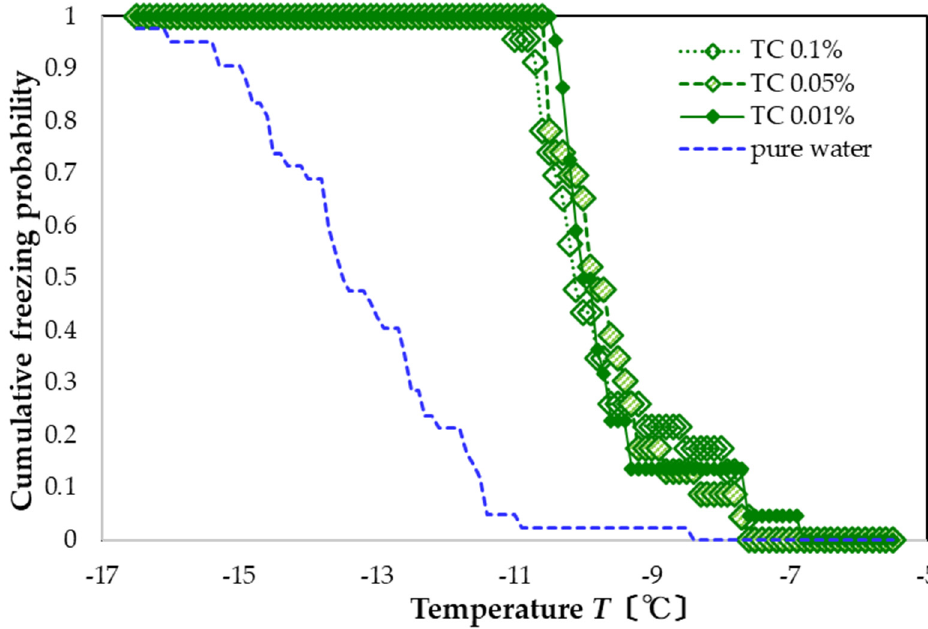
Figure 4. Freezing curves of TC solutions. Leftmost blue-dashed curve is the freezing curve of pure water.